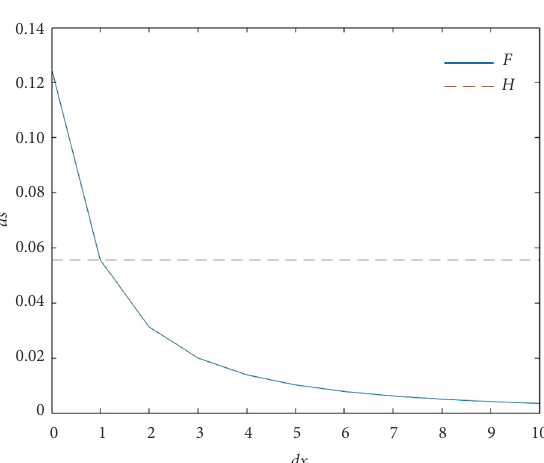
Figure 12. The rate of change in area